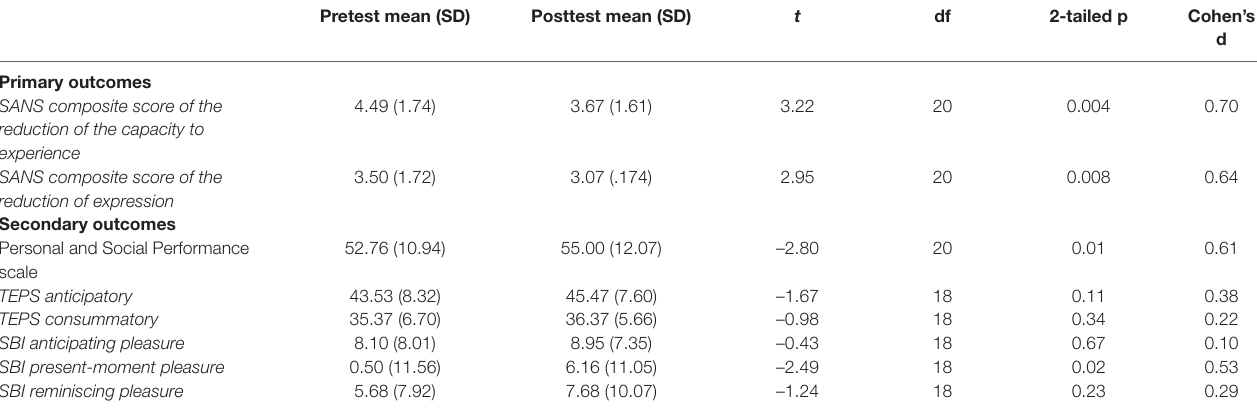
TABLE 1 | Pre- and Posttest Results from the Different Scales.